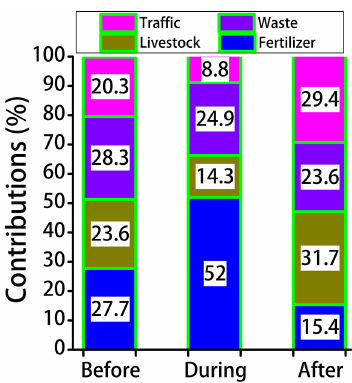
Figure 4. The overall contribution proportion (%) of the four sources to ambient NH 3 identified by the IsoSource before, during, and after the APEC summit in